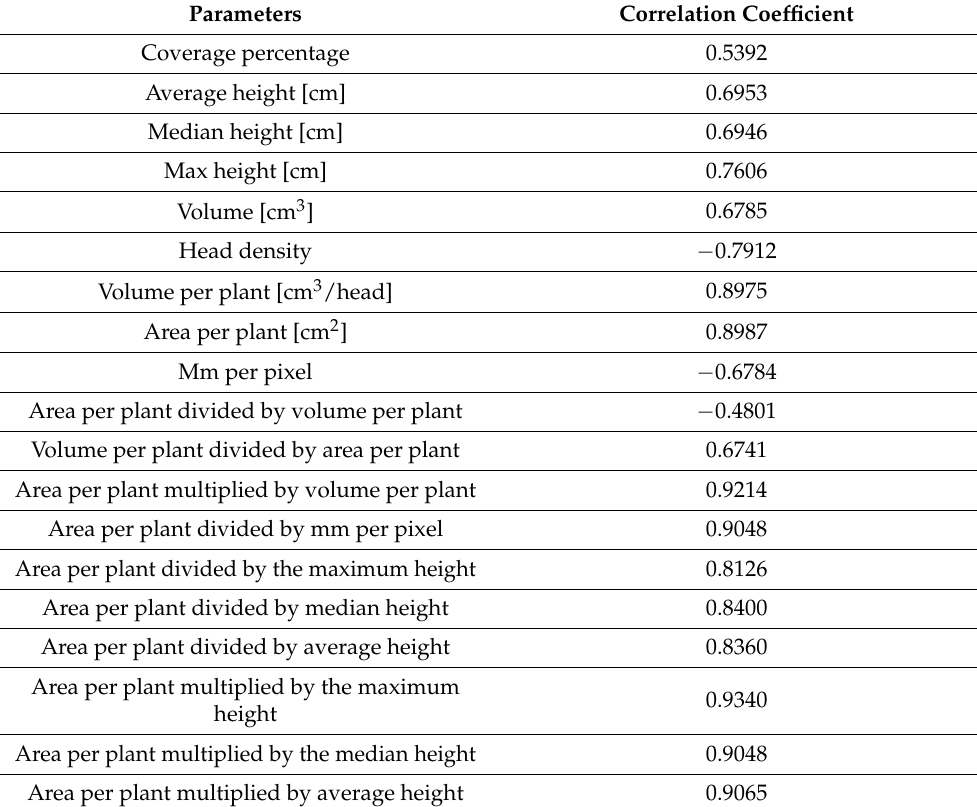
Table A4. Correlation coefficient between measured and predicted fresh weight using corresponding parameters derived using RGB and depth